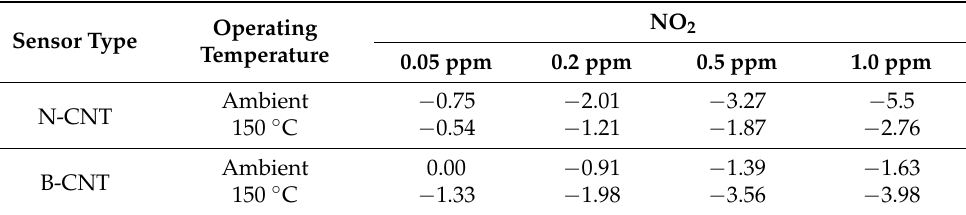
Table 3. Experimental gas sensing responsiveness, S, for nitrogen- and boron-doped nanotubes at an ambient temperature and 150 ◦ C for different gas concentrations. Republished with permission of Elsevier from